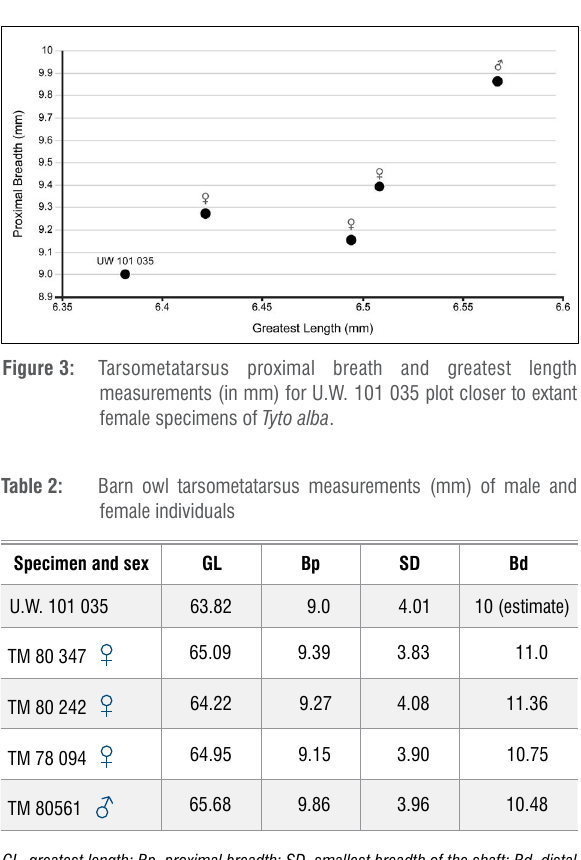
figure 4: (a) Specimen U.W. 101 40C, a left tibiotarsus fragment of Tyto alba , with the mid-distal shaft present, and part of the distal condyle; (b) specimen U.W. 101 40B, a right radius fragment of Tyto alba , consisting of the distal, mid and proximal shaft, with the distal styloid process absent; (c) specimens U.W. 101 965 and 822, a right ulna fragment of Tyto alba , consisting of the proximal, mid and distal shaft, with a small portion of the distal articulation present.